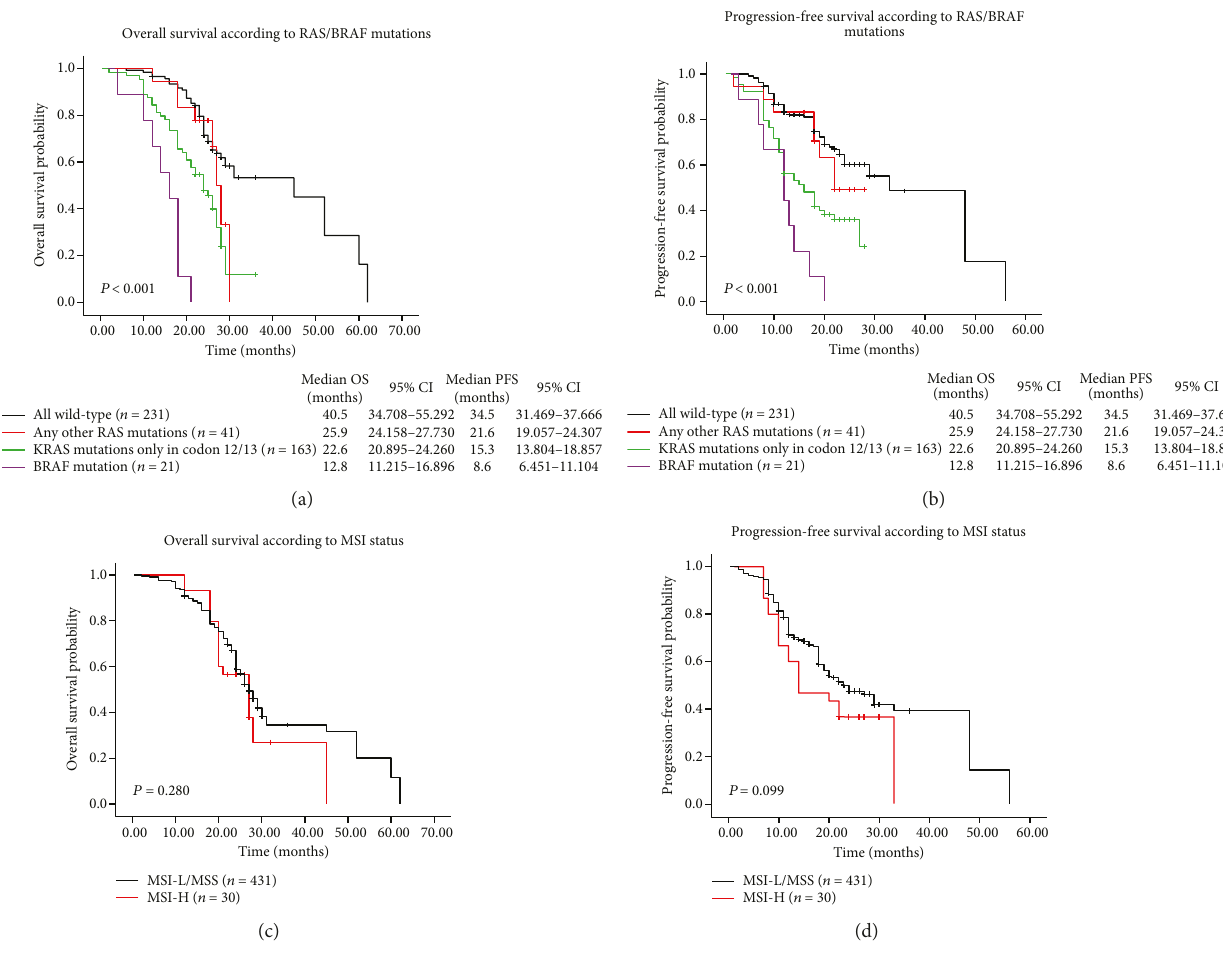
Figure 4: Kaplan-Meier survival curves of metastatic colorectal carcinoma patients. (a) OS and (b) PFS of patients with di ff erent gene mutations; (c) OS and (d) PFS (MSI-L/MSS versus MSI-H) of entire study population. OS: overall survival; PFS: progression-free survival; MSI: microsatellite instability; MSI-L: MSI-low; MSI-H: MSI-high; MSS: microsatellite